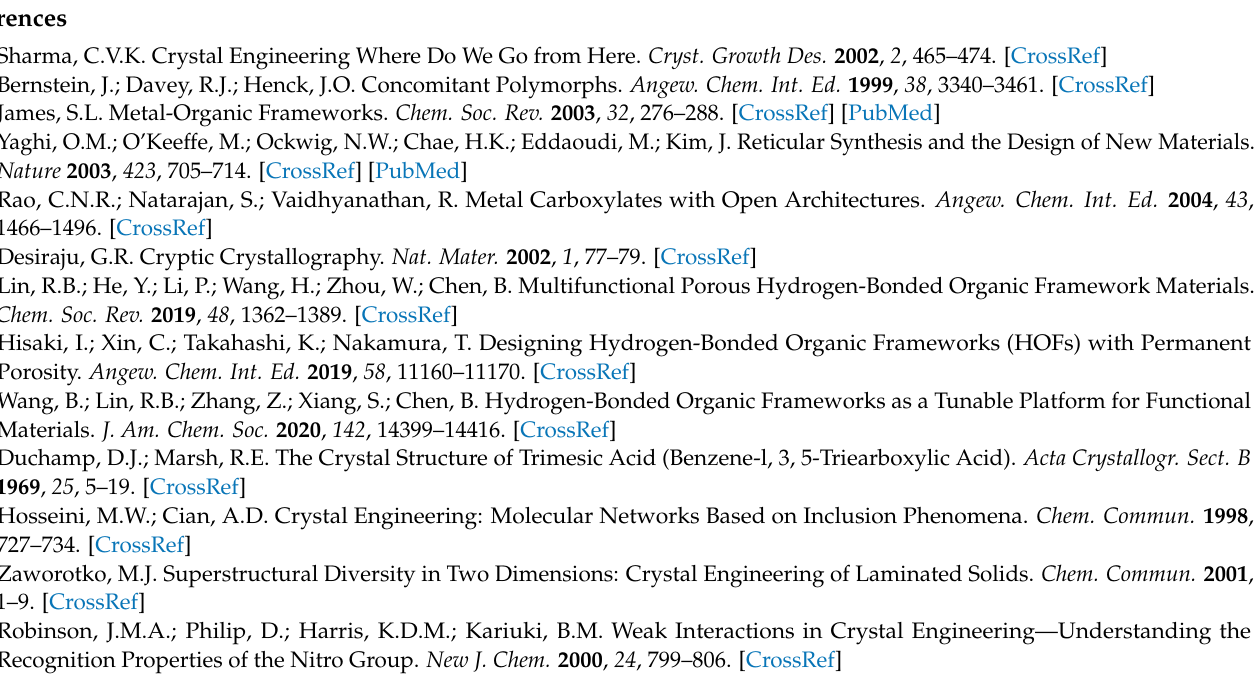
Figure S4: Asymmetric unit of compound (4), with atom labels and 50% probability displacement ellipsoids. Figure S5: Asymmetric unit of compound (5), with atom labels and 50% probability dis-placement